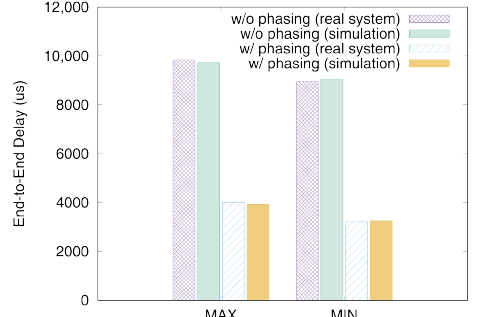
Figure 11. Max and min D e 2 e of VC 0 in test set 0.